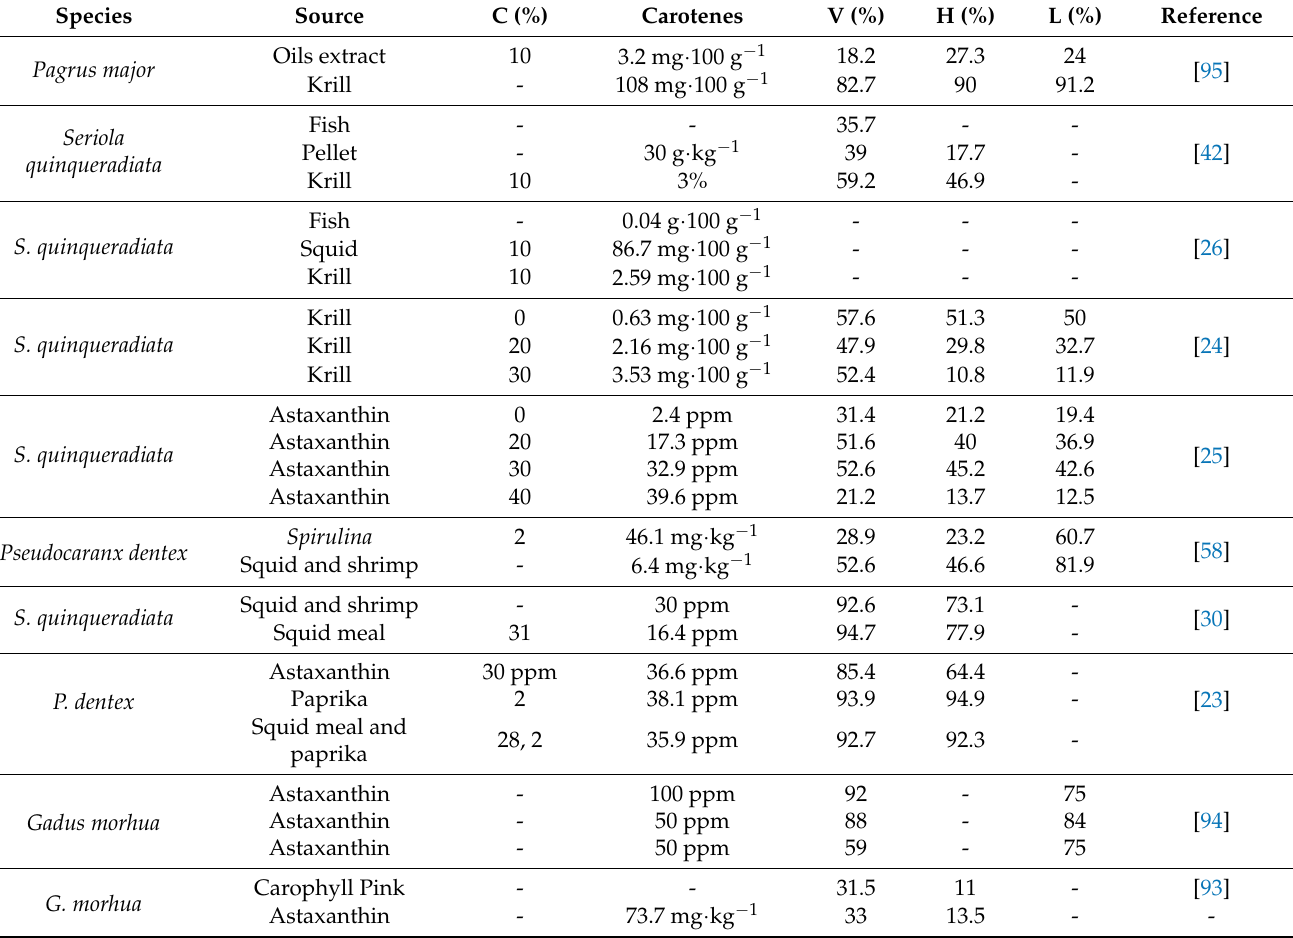
Table 10. Reproductive performance in different species with the addition of carotenoids in the diet. C: Concentration; V: Viability; H: Hatching; L: